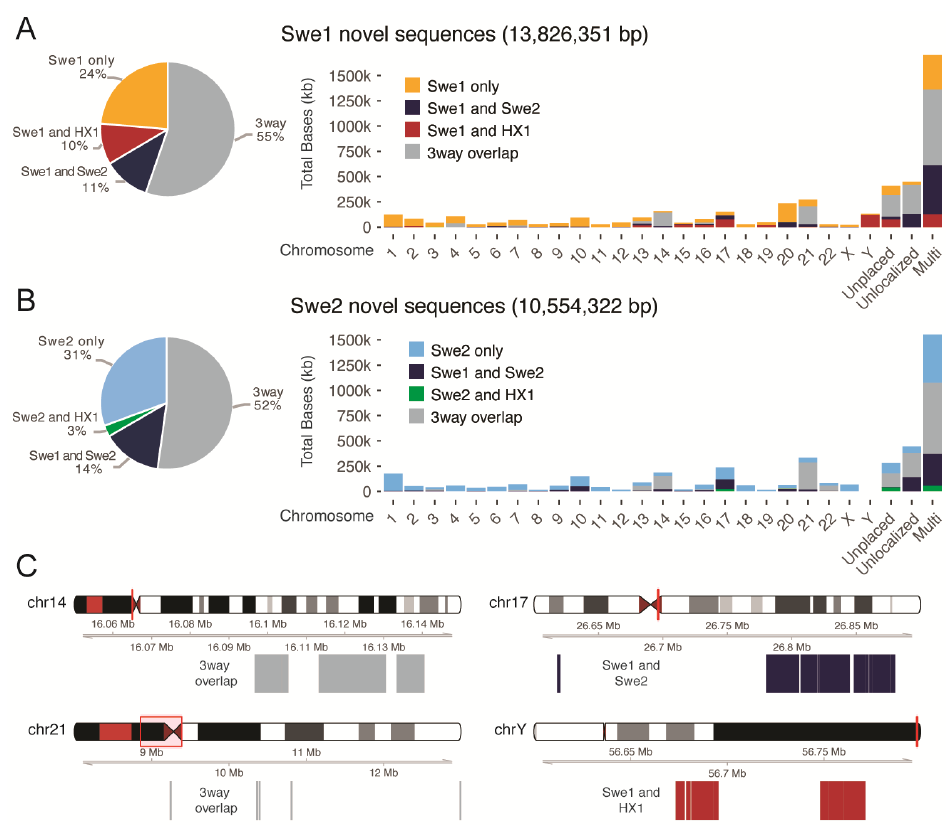
Figure 3. Anchoring of Swe1 and Swe2 NS to the hg38 reference. ( A ) The pie chart to the left shows the proportion of Swe1 NS (in total 13.8 Mb) that are also found in Swe2 or in the Chinese HX1. The category 3way (grey) represents NS that are found in all three individuals. The bars to the right show the amount of NS that can be anchored to the hg38 genome. The category unplaced represents sequences in hg38 that are not associated with any chromosome, and unlocalized corresponds to sequences that are associated with a specific chromosome but have not been assigned an orientation and position. The multi category furthest to the right represents NS that are mapping to multiple chromosomes. ( B ) Similar results for NS detected in Swe2. ( C ) Examples of chromosomal regions where a high amount of NS are detected. The two plots to the left show the localization of 3way overlap sequences (i.e., found in Swe1, Swe2, and HX1) near the centromeric regions of chr14 and chr21. The top right panel displays a region on chr17 where an excess of NS found only in Swe1 and Swe2 could be anchored. The bottom left panel shows NS detected only in the two males (Swe1 and HX1) that could be anchored to regions close to the telomere of chromosome Y.